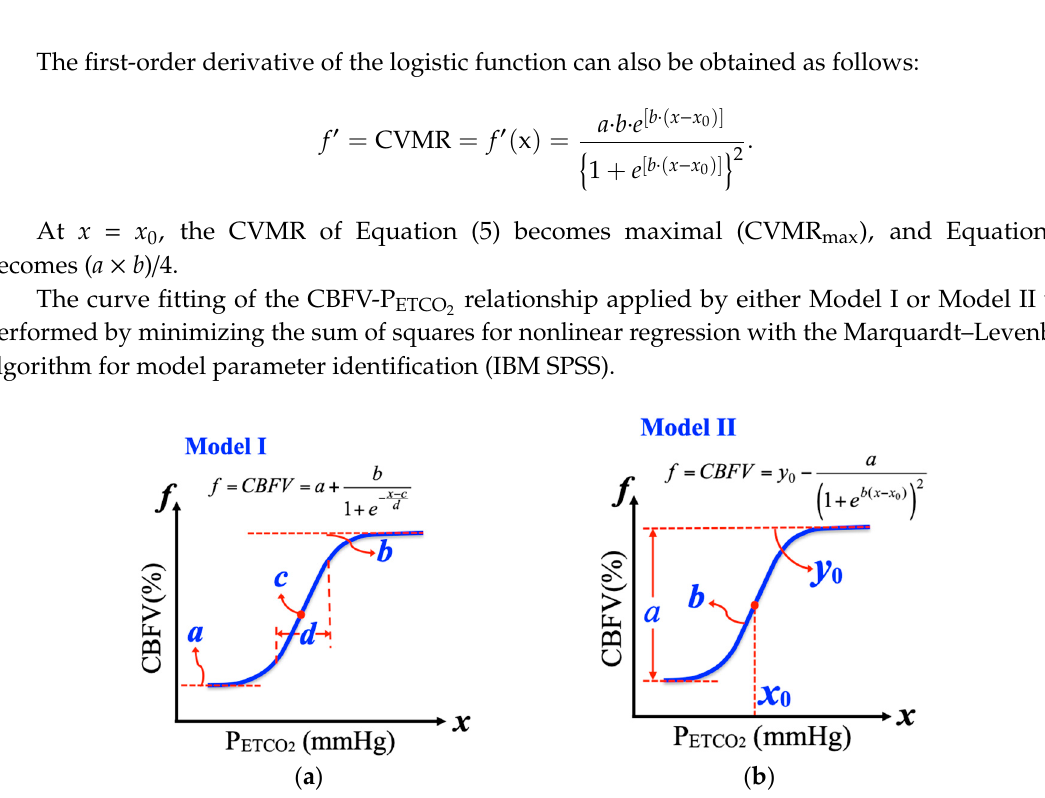
Figure 2. Schematic representation of the logistic function Models I and II, each with four parameters to be identified. ( a ) Model I: f represents a percentage change in CBFV, x represents P ETCO 2 with units of mmHg, a is the minimum CBFV% of the hypocapnic region, b is the maximum CBFV% value, c is the midpoint value of CBFV%, and d is the range of the linear portion of the curve. ( b ) Model: f represents percentage change in CBFV and x represents P ETCO , a represents the range of change in CBFV%, 2 y 0 is the maximum value of CBFV during hypocapnia, x 0 is the level of P ETCO where the first-order 2 derivative of the logistic function is maximal, and b is related to the overall curvilinear properties of the sigmoidal